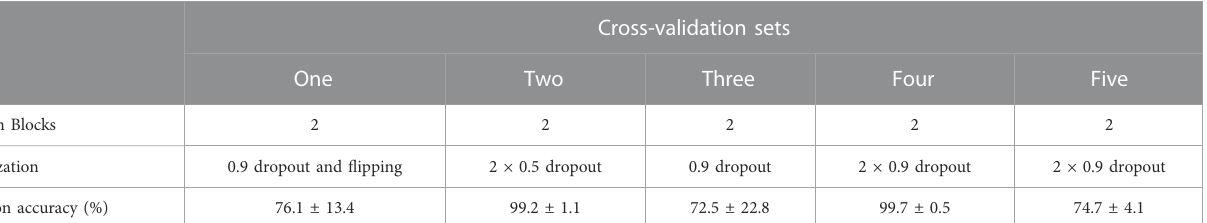
TABLE 2 Results for the highest validation accuracy models trained on each set of